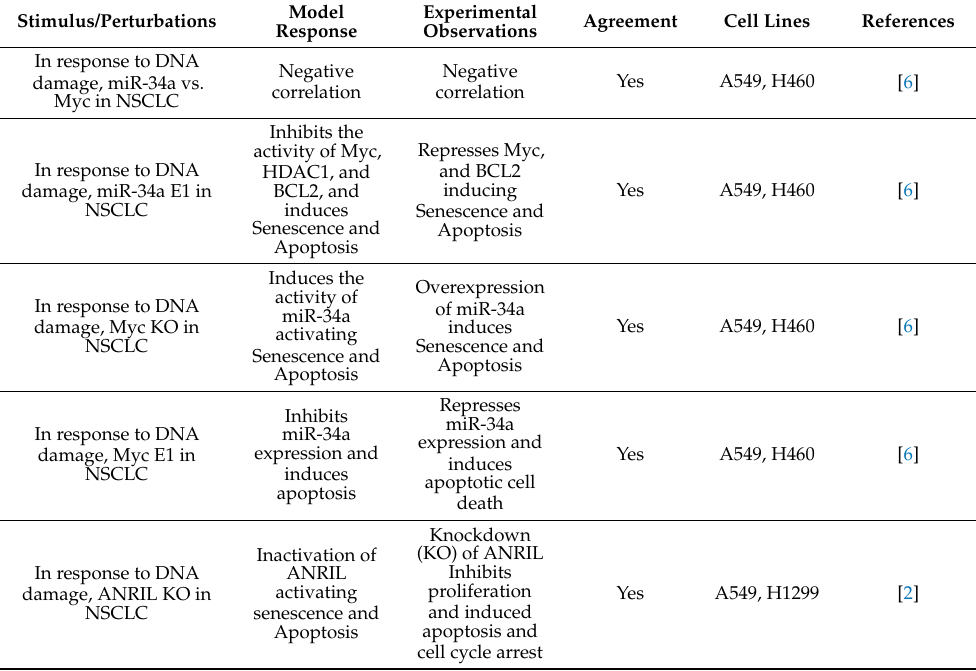
Table 1. Agreement between proposed Boolean Network and experimental data from the literature. Ectopic expression (E1) represents gain of function (GoF) and Knockdown (KO) represents loss of function (LoF) of the corresponding molecule. Cases for which no experimental data were found are indicated by